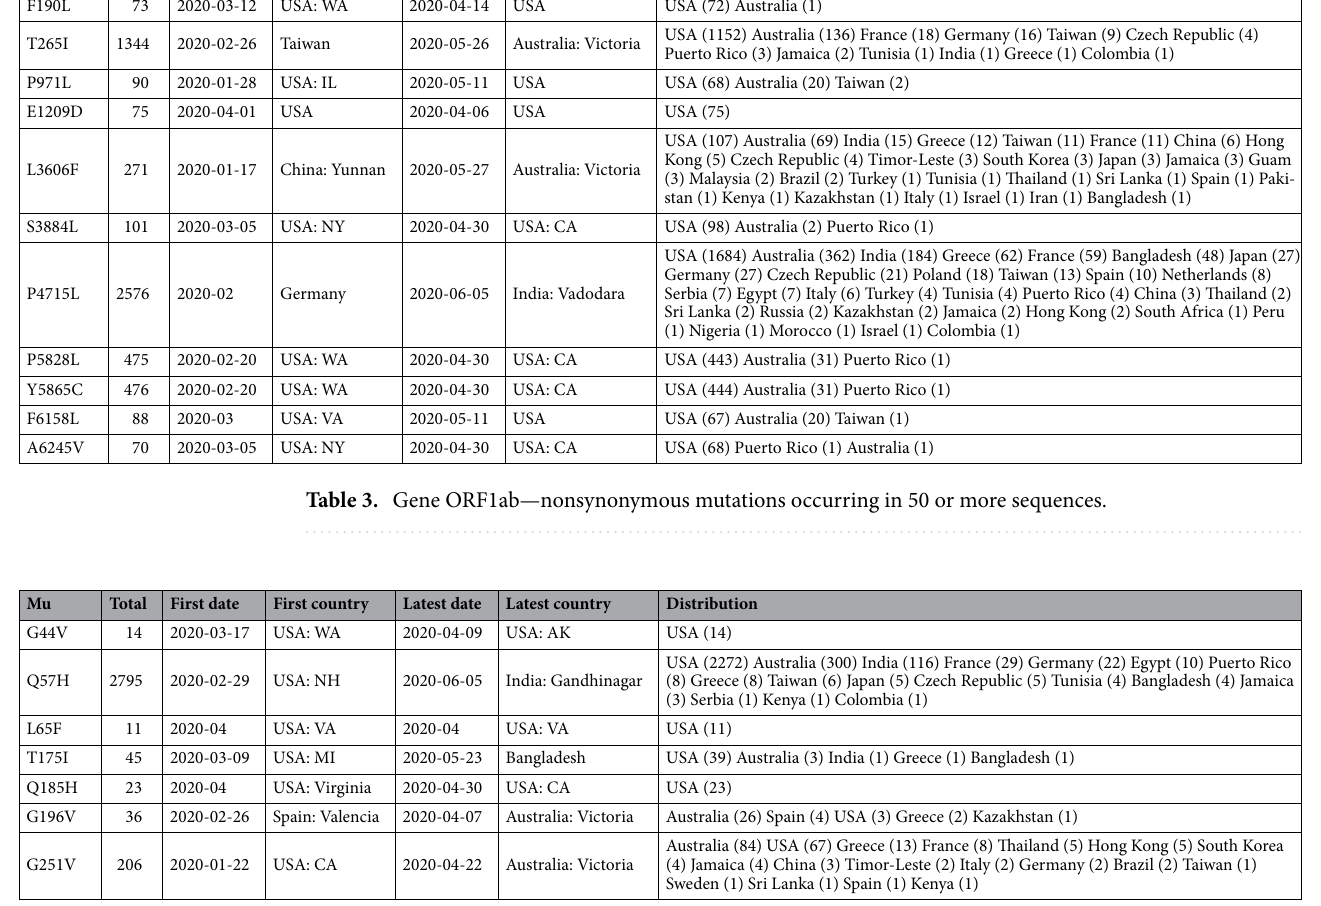
Table 4. Gene ORF3a—nonsynonymous mutations occurring in 10 or more